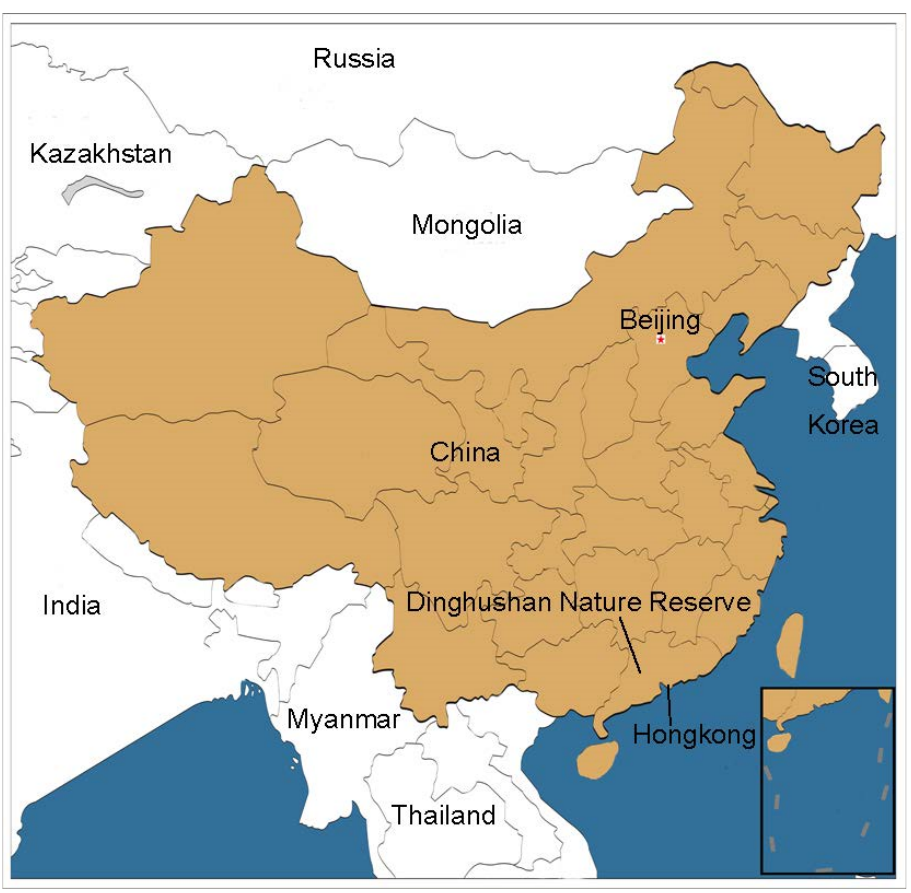
Figure 1. Location of the study plot.